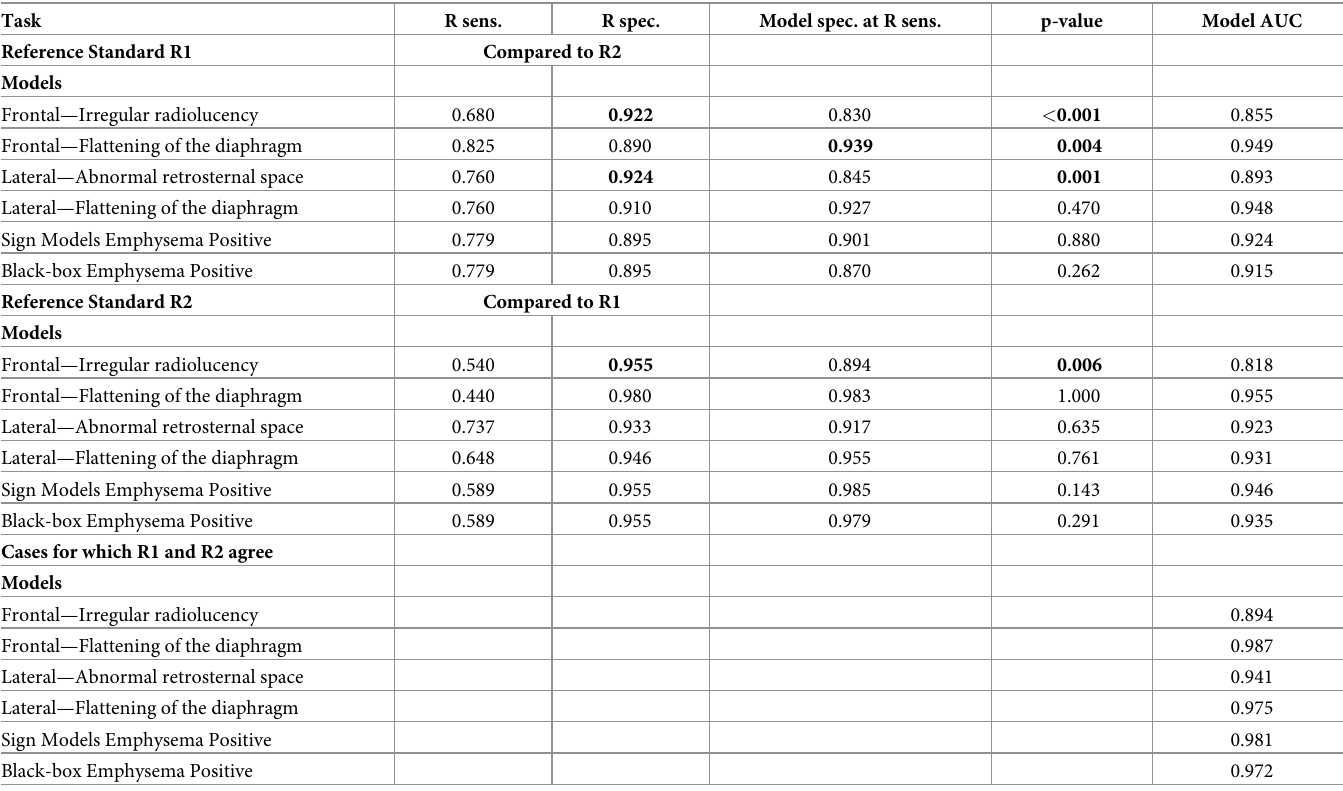
Table 5. Comparison of the radiologists and the models. Task R sens. R spec.